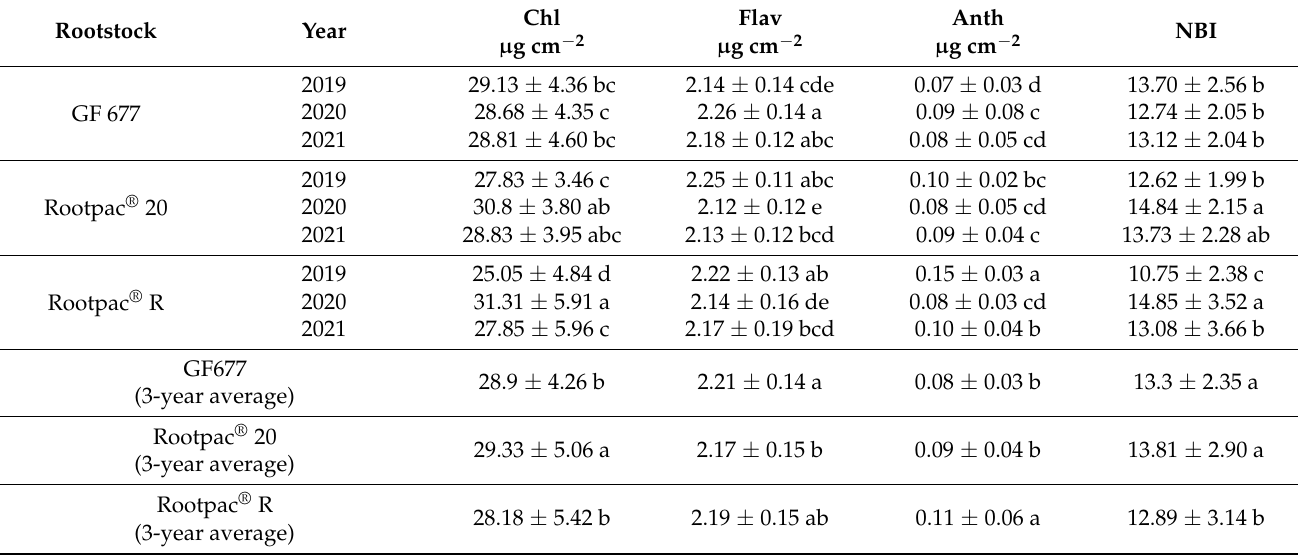
Table 3. Content of total chlorophyll ( µ g cm − 2 ), flavonol ( µ g cm − 2 ) anthocyanin ( µ g cm − 2 ), and nitrogen balance index (NBI) in leaves of cultivar ‘Guara’ collected from plants of trial B. Data are reported as mean ± standard deviation per year and as three-year mean ± standard deviation. Different lowercase letters on the columns indicate significant differences between treatment and year (Fisher’s test p < 0.05).